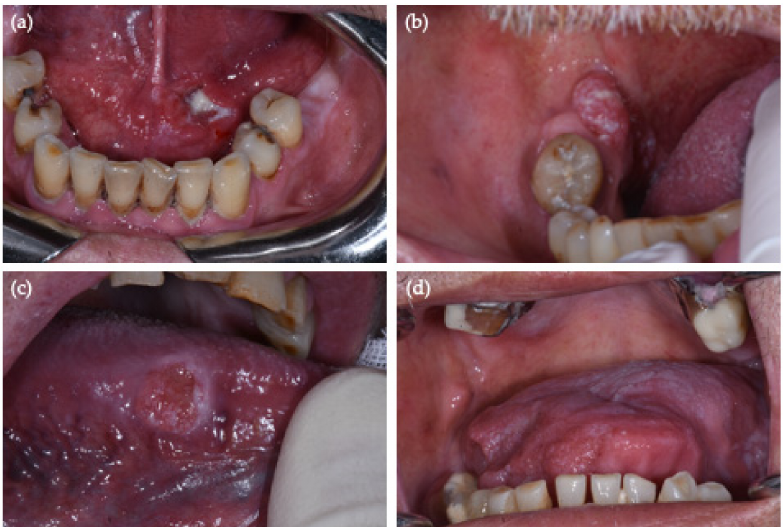
Figure 1. HPV-positive OSCCs: ( a ) anterior oral floor (C04.0—hrHPV 51) and ( b ) retromolar area (C06.2 hrHPV 67) were p16 positive—PCR HPV-DNA positive; ( c ) border of the tongue (C02.1— hrHPV 31 + 68) and ( d ) border of the tongue (C02.1—hrHPV 66) were PCR HPV-DNA positive